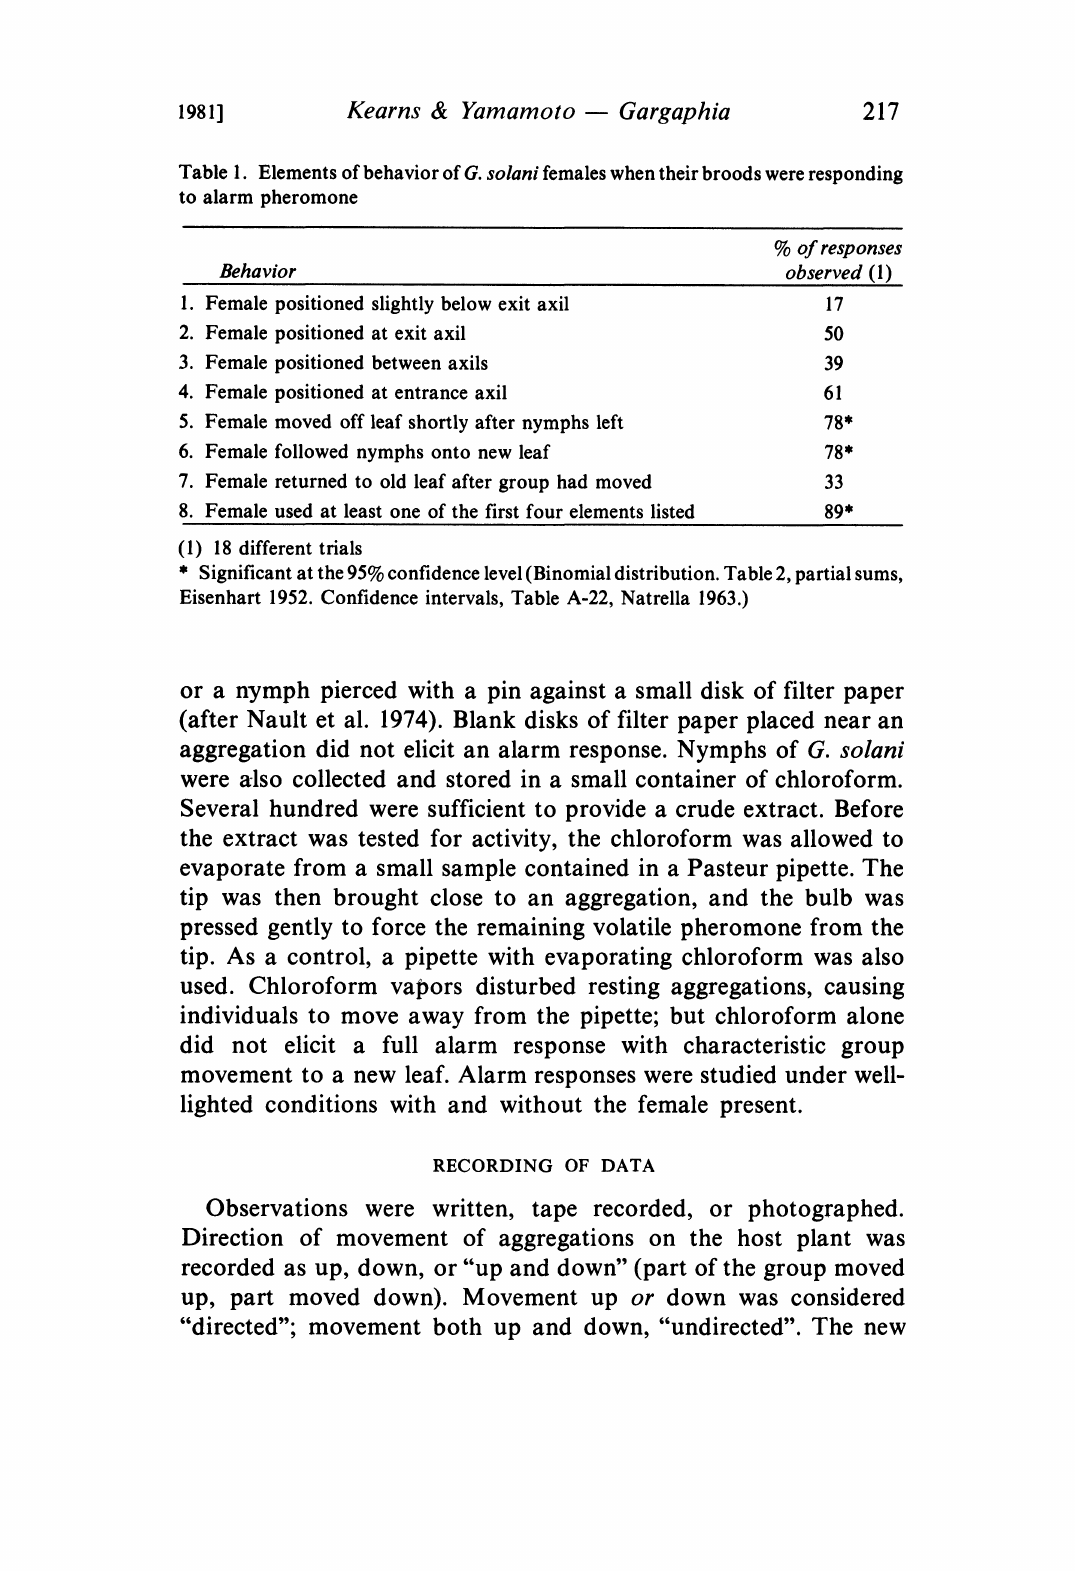
Table 1. Elements of behavior of G. solani females when their broods were responding to alarm